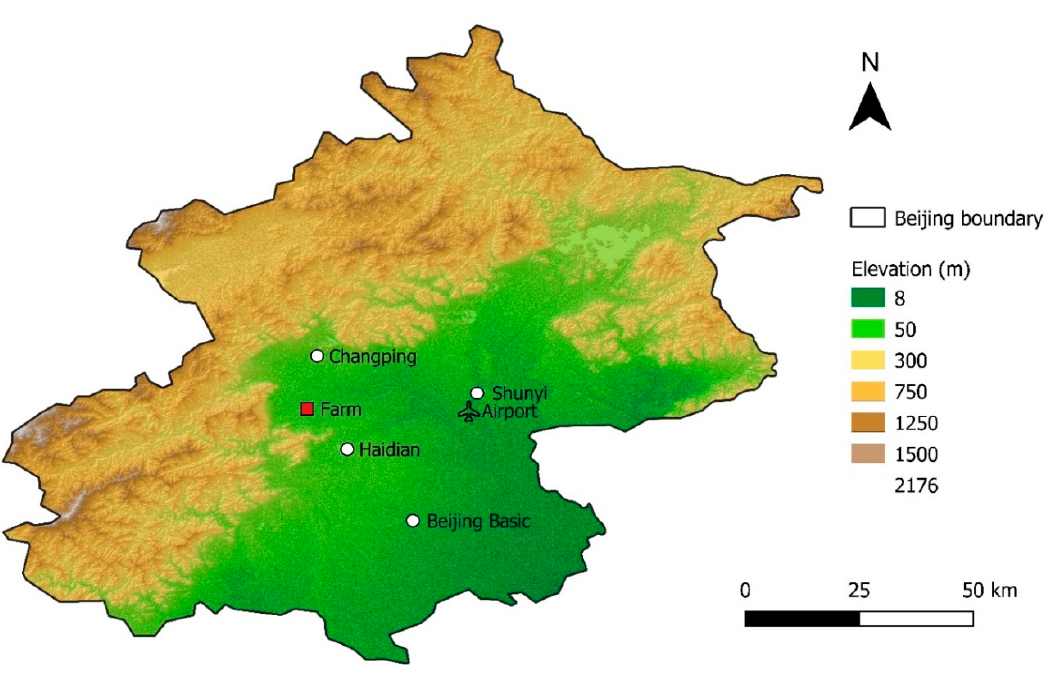
Figure 2. The spatial pattern of topography in Beijing, China, showing the location of the dairy farm and the meteorological stations selected for data scrutiny. Table 2. Information on the meteorological stations examined in this study (data period: 2017).